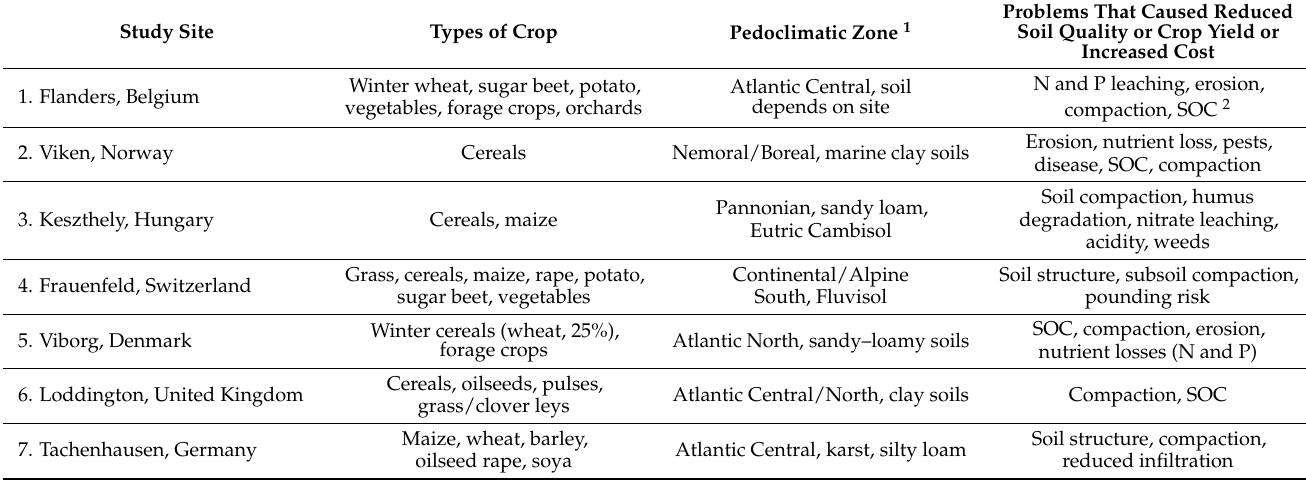
Table 1. Overview of SoilCare study sites. Types of crops listed here represent the study site region, not the sites where monitoring was